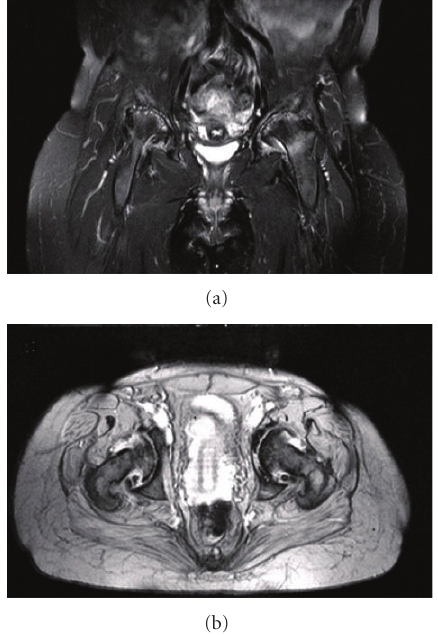
Figure 6: (a) MRI coronal FS view of the pelvis and (b) MRI axial ME 2D view of the